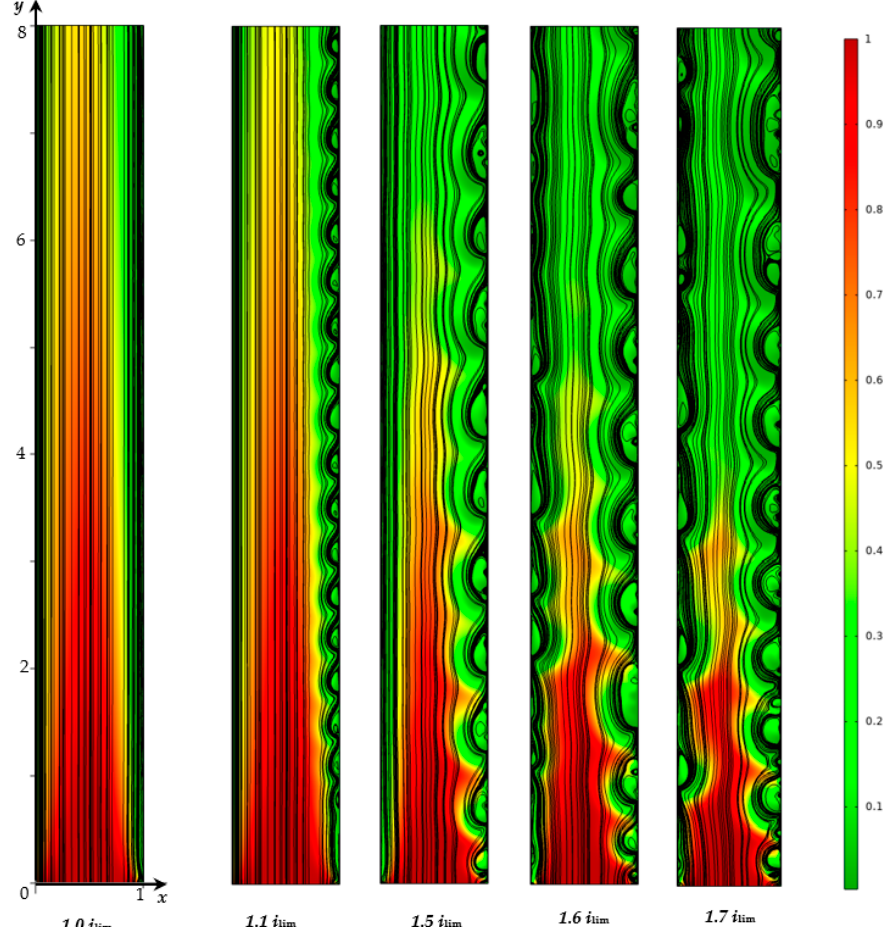
Figure 4. Solution streamlines (black lines) and cation concentration distribution (shown in color) in the quasi-stationary state ( t = 40, which corresponds to 100 s), calculated for current density values i av / i lim = 1, 1.1, 1.5, 1.6,